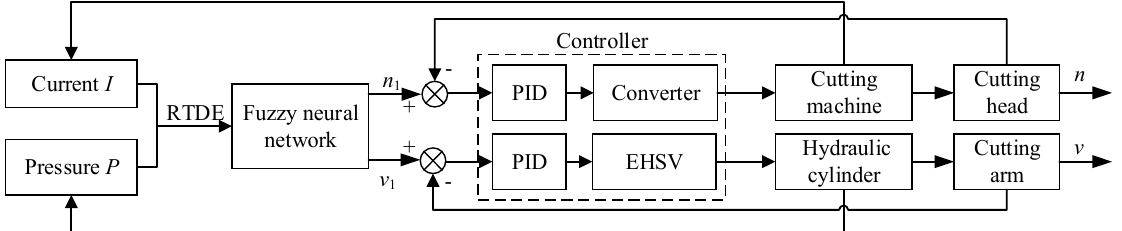
Figure 6. Adaptive variable speed cutting control strategy diagram.